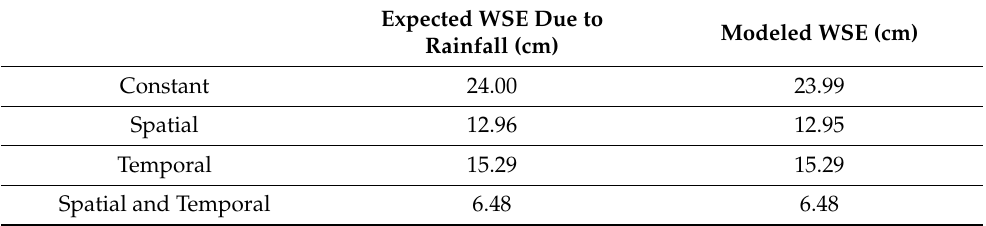
Table 1. Comparison of water surface elevations for idealized rainfall tests cases with constant ba- thymetry.